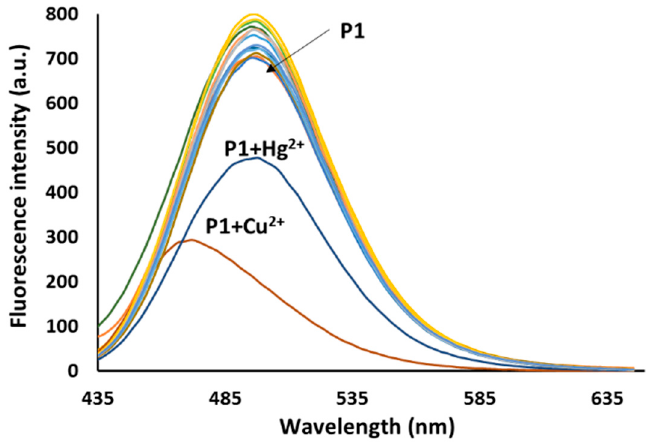
Figure 4. Emission spectra of P1 (7 × 10 − 5 g/L) in the presence various metal ions (10 µ L of 0.05 M solution) in acetonitrile. Excitation was performed at 395 nm.